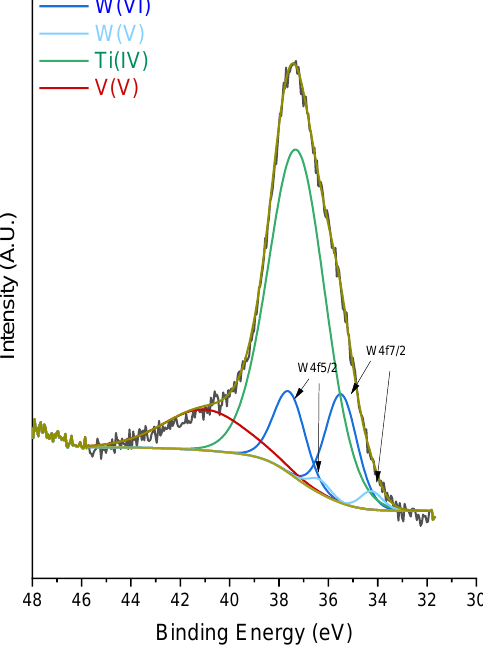
Figure 6. W4f, Ti3p and V3p